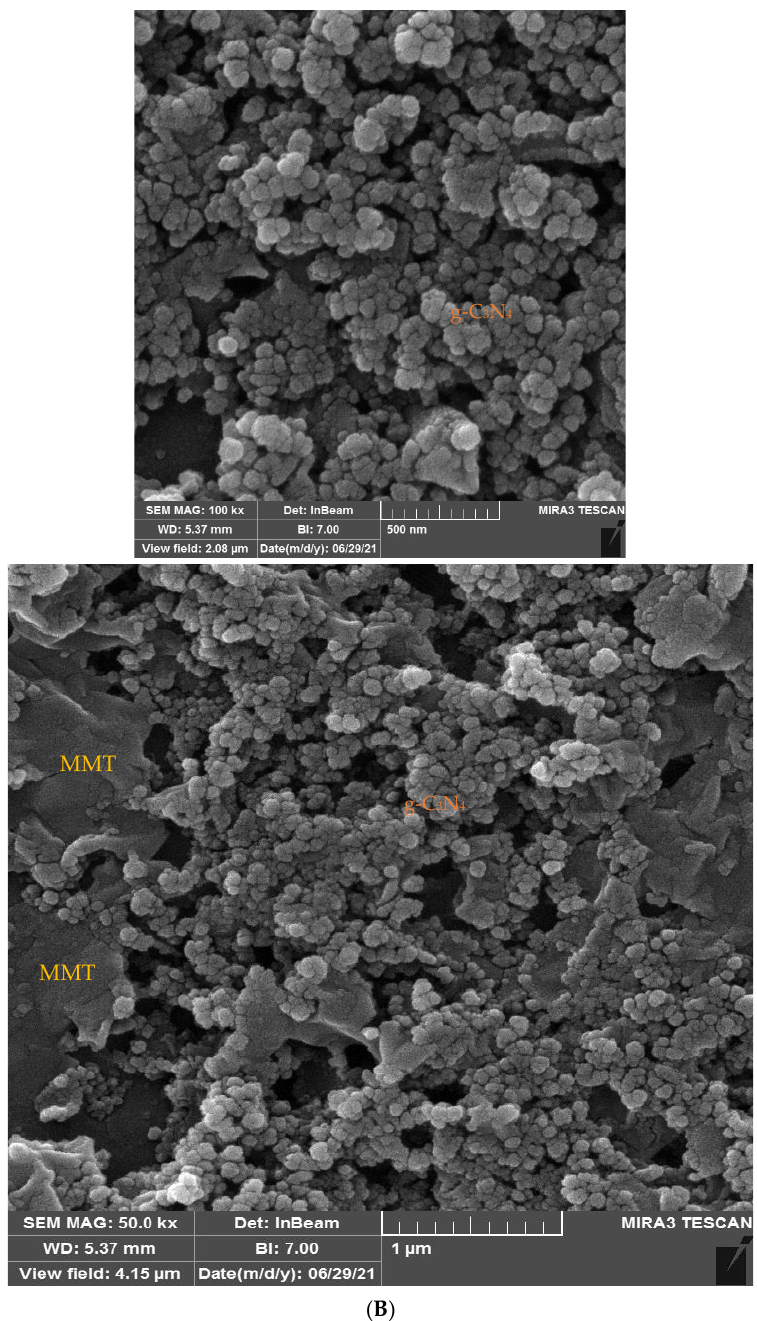
Figure 1. ( A ) TEM images of g-C 3 N 4 and ( B ) FESEM images of MMT/g-C 3 N 4 . ( A ) The scale bar is at the bottom of right corner.